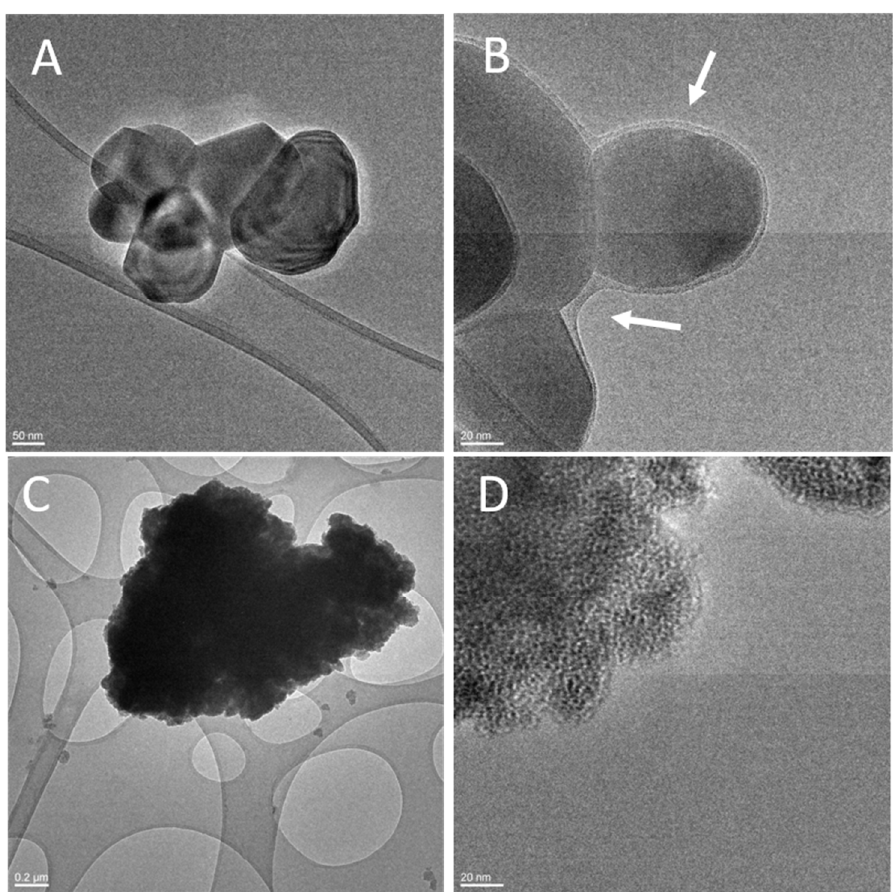
Figure 3. TEM analysis of the TiO 2 NMs after incubation in the stock suspensions: ( A , C ) traditional protocol; ( B , D ) standardized protocol; ( A , B ) NM-100; ( C , D ) NM-101.